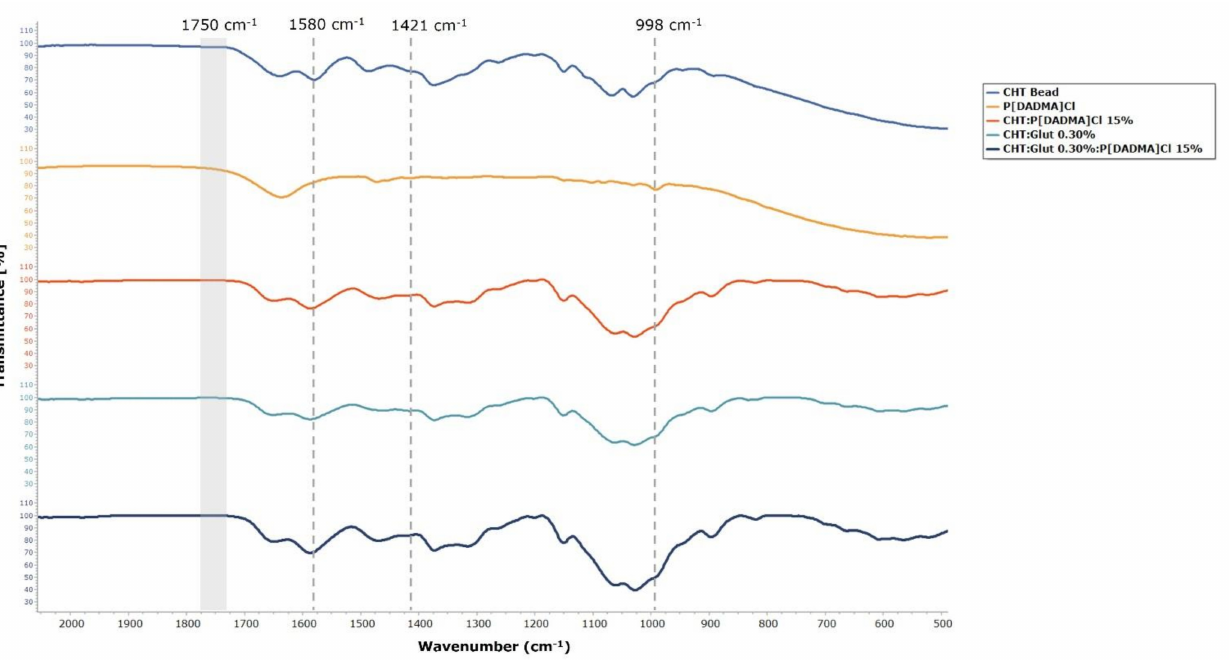
Figure 3. ATR–IR spectra of (blue) CHT bead, (orange) P[DADMA]Cl, (red) CHT:P[DADMA]Cl 15% bead, (cyan) CHT:Glut 0.30% bead, and (dark blue) CHT:Glut 0.30% :P[DADMA]Cl 15% bead. 13 C CP-TOSS NMR spectra (Figures 4 and S4) also confirms the PIL incorporation into the aerogel and the cross-linking of chitosan with glutaraldehyde. These differences are observable in the aromatic region (125–155 ppm) due to the benzyl substituent and the aliphatic region (40–55 ppm) due to the amine alkyl substituents. The most promising beads which presented higher specific surface areas were analysed through SEM imaging. In Figure 5, images of AEROPILs containing P[DADMA][OAc] with and without cross-linker (glutaraldehyde) are presented. Images of chitosan beads with the same amount of cross-linker are also provided for comparison (Figure 5a,b). The dual porous structure was confirmed in the inner and outer structure of the particles.